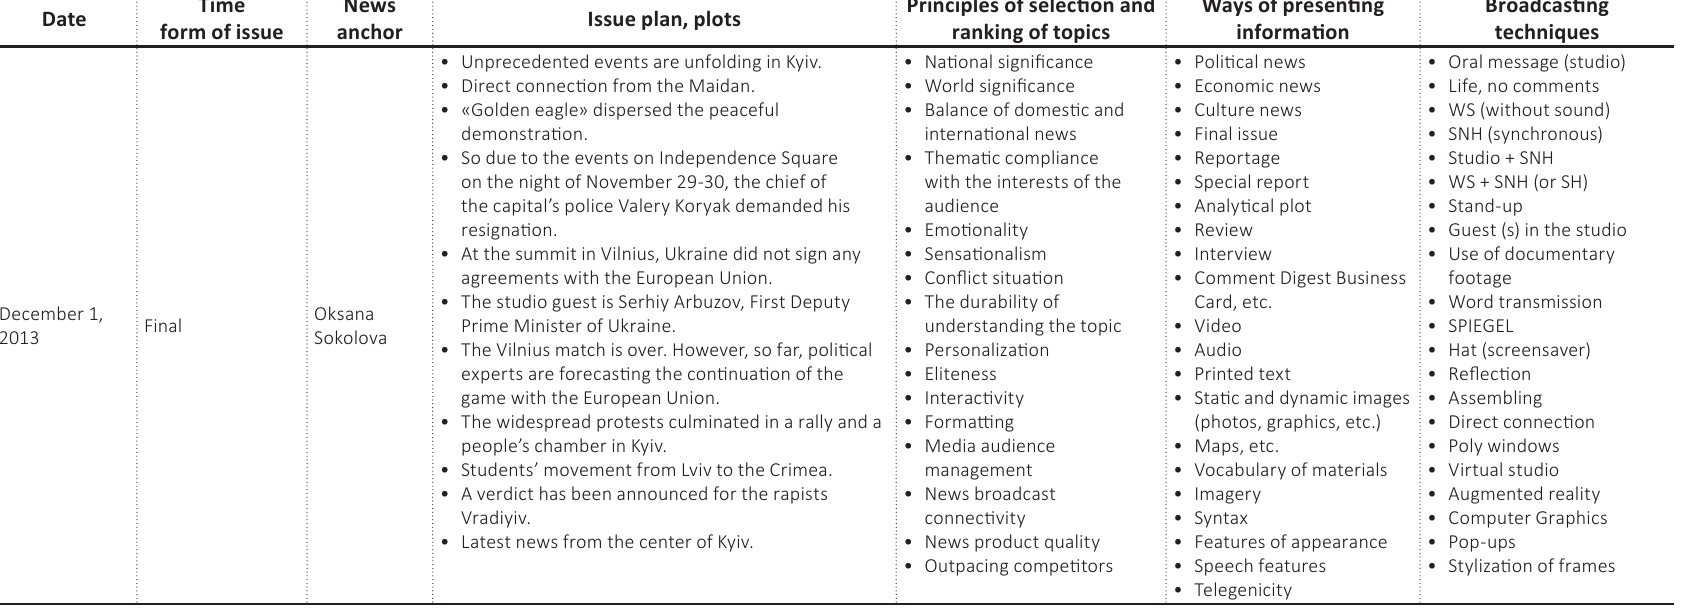
Table A1. Layout of ICTV news program “Fakty” (example of rhetorical analysis of a news release) Time Date form of issue